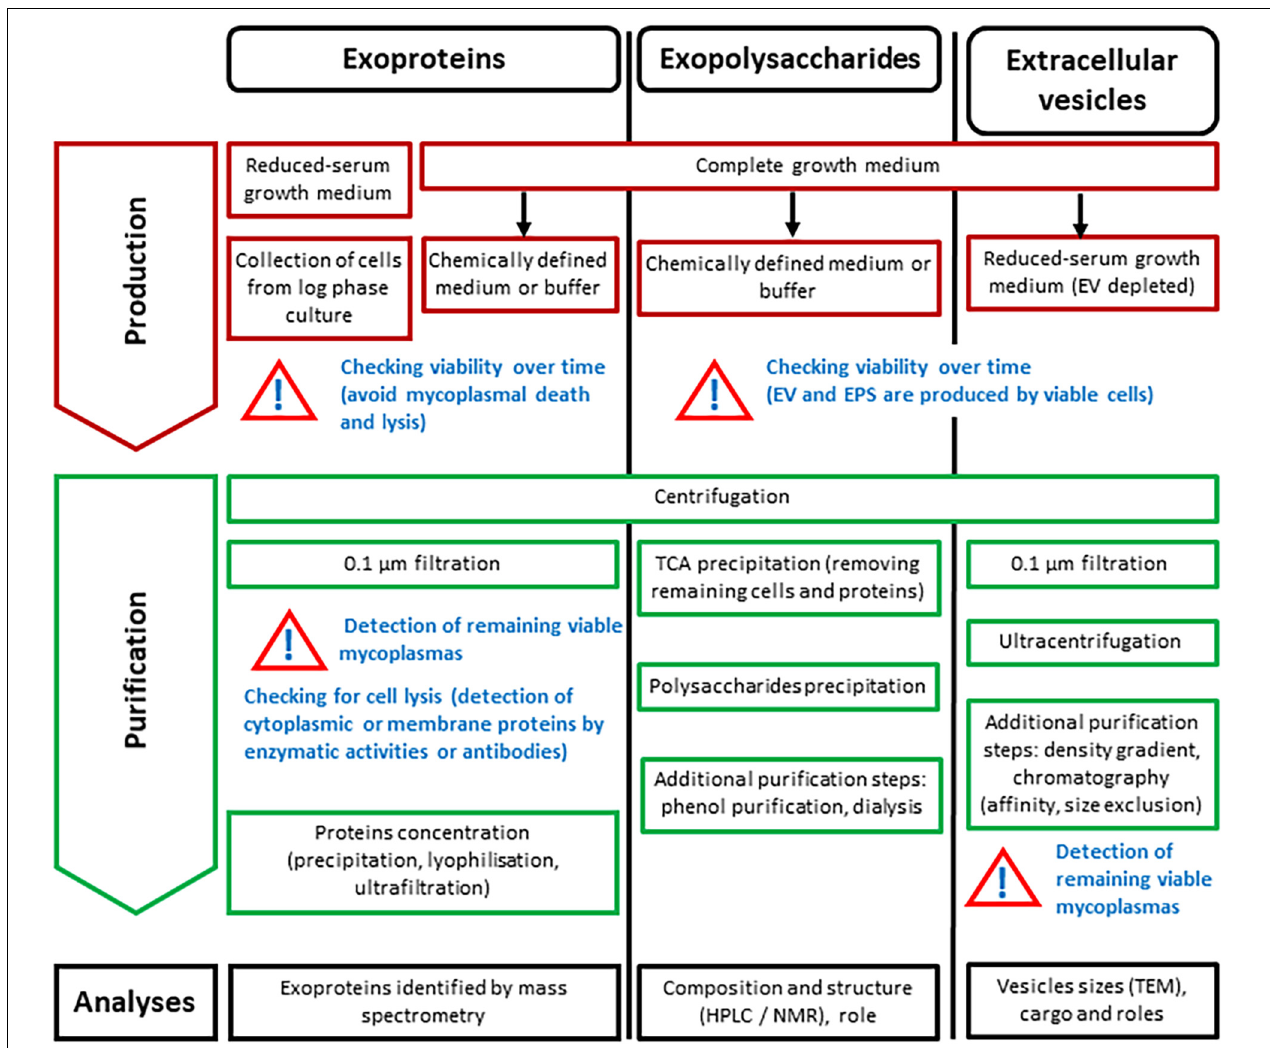
FIGURE 2 | Strategies for in vitro production and purification, as well as analysis of exoproteins, exopolysaccharides and extracellular vesicles for characterization of the Mycoplasma releasome. Black arrows: switch